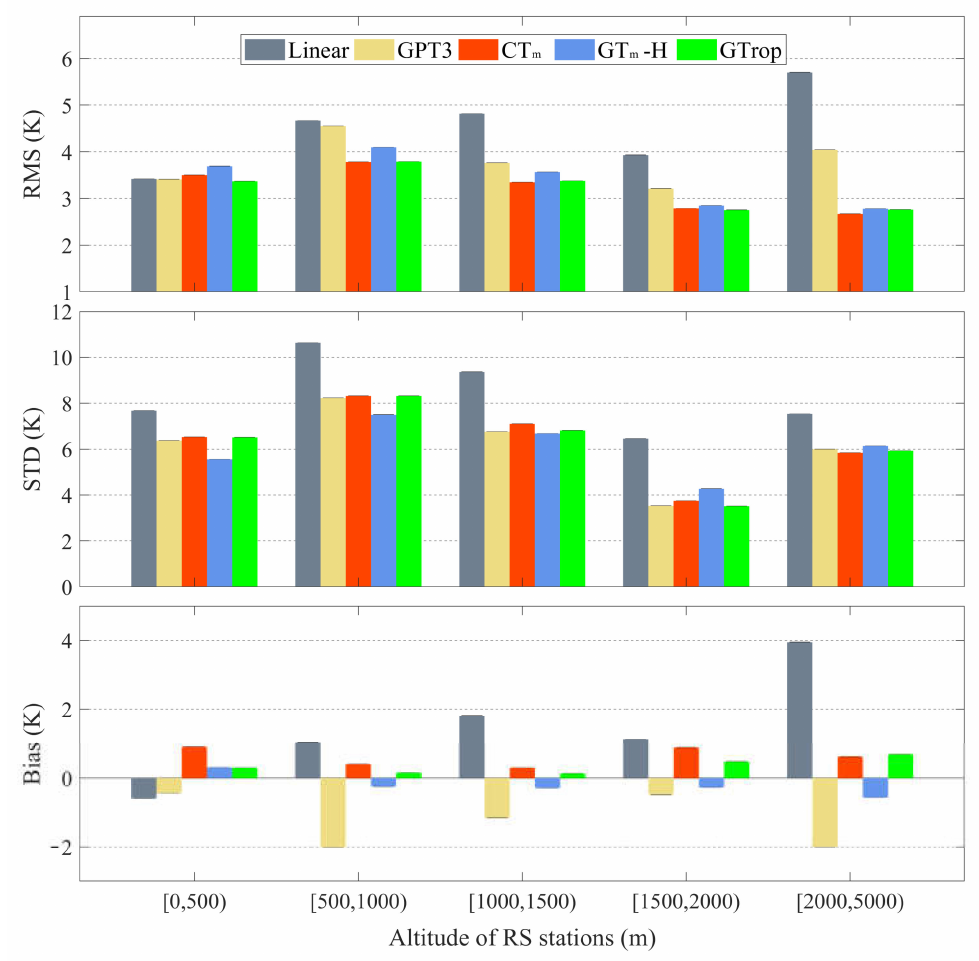
Figure 3. Average RMS and Bias of the five T m models at different altitude ranges over the period of 2011 to